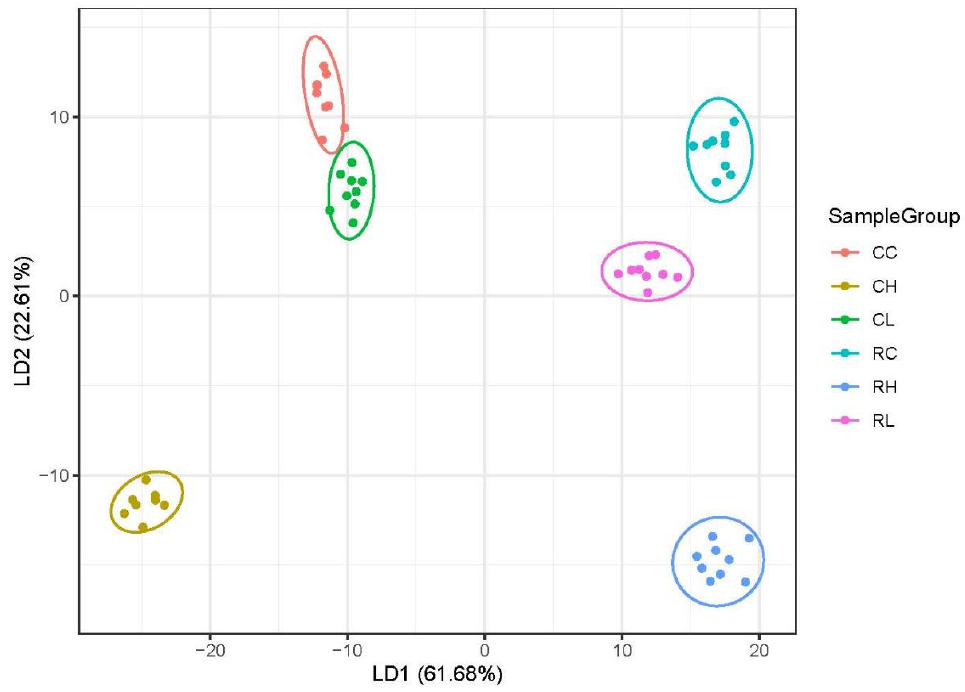
Figure 4. Linear discriminant analysis of Pinot noir wines by winemaking conditions with 25 selected important variables out of 243 lipid species as dependent variables and six winemaking conditions as independent variables. (RC: 27 ◦ C fermentation temperature, 0 g/L yeast product addition; RL: 27 ◦ C fermentation temperature, 0.5 g/L yeast product addition; RH: 27 ◦ C fermentation temperature, 1 g/L yeast product addition; CC: 16 ◦ C fermentation temperature, 0 g/L yeast product addition; CL: 16 ◦ C fermentation temperature, 0.5 g/L yeast product addition; and CH: 16 ◦ C fermentation temperature, 1 g/L yeast product